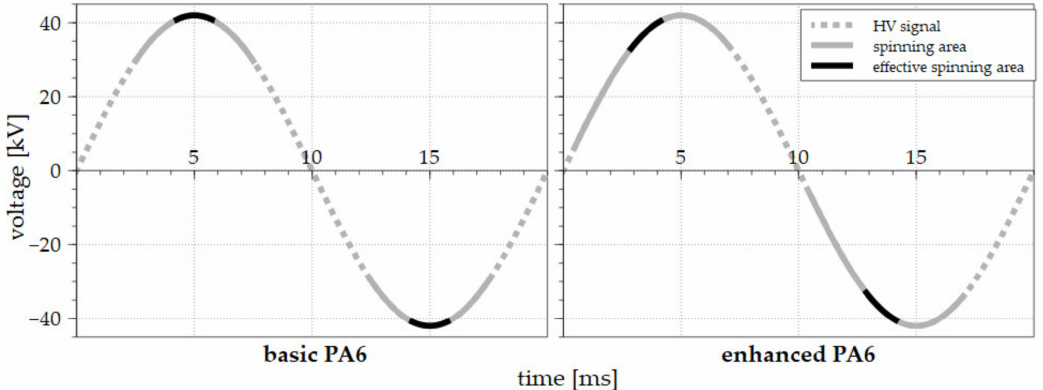
Figure 3. The AC electrospinning processes driven by the sinus wave signal for the basic PA 6 solution ( left ) and the enhanced solution ( right ). The voltage signals are represented by the dotted gray lines, the spinning areas are shown as a solid gray line, and the effective electrospinning areas are highlighted by solid black